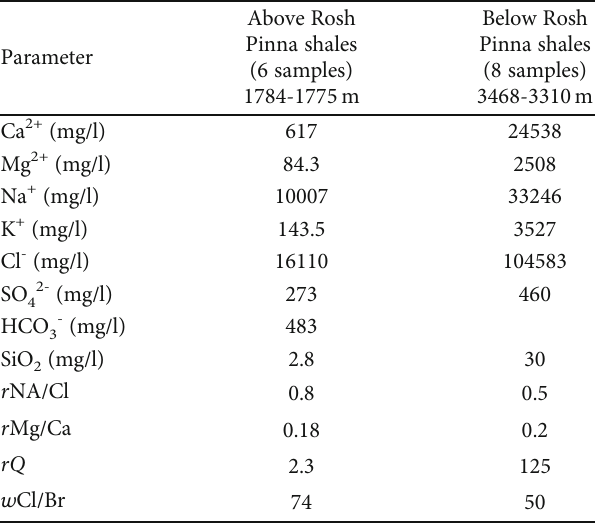
Table 3: Averaged concentrations of chemical components and ionic ratios in the Jurassic (Arad Group) interval. Cl - /Br - are in weight ratio; all other ratios are based on